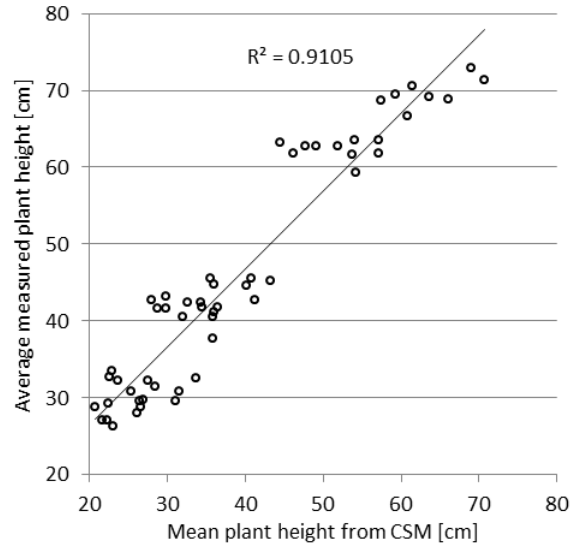
Figure 5. Regression of mean plant height calculated from CSM and manually measured plant height